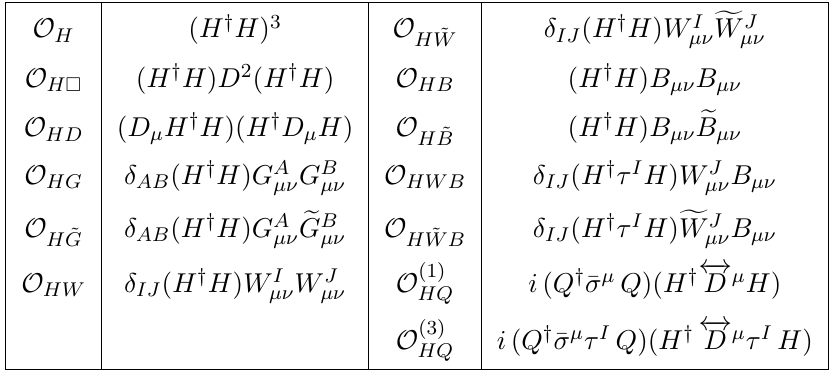
Table 8 . The thirteen dimension-6 operators included for comparison with dimension-8 e(cid:11)ects. As described in the text, we work with the Warsaw